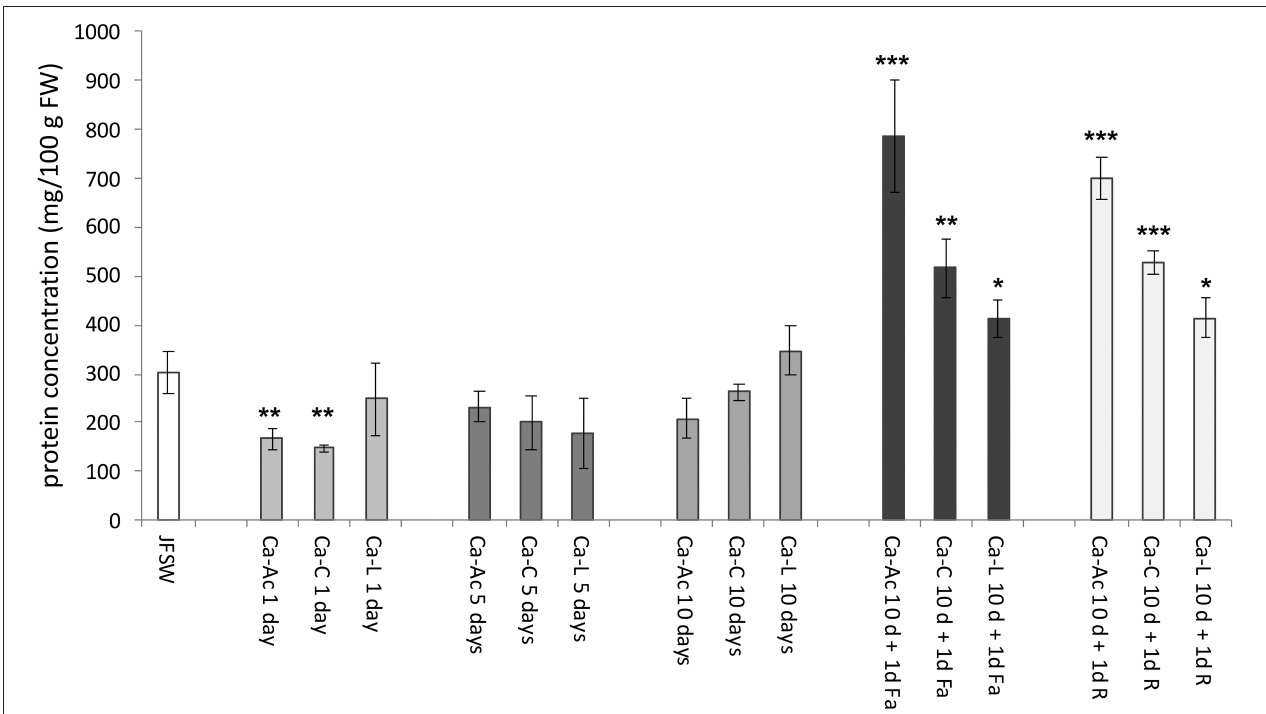
FIGURE 2 | Protein concentration in JF samples. Protein contents expressed as mg per 100g of FW (mg/100g FW) in control [jellyfish washed with sterile sea water (JFSW)] and in the different treatments used: Ca-Ac (calcium acetate), Ca-C (calcium-citrate), Ca-L (calcium lactate) for 1, 5, and 10 days; Ca-Ac 10 d + 1d Fa (ferulic acid added to JF already treated for 10 days with Ca-Ac), Ca-C 10 d + 1d Fa (ferulic acid added to JF already treated for 10 days with Ca-C), Ca-L 10 d + 1d Fa (ferulic acid added to JF already treated for 10 days with Ca-L), Ca-Ac 10 d + 1d R (rutin added to JF already treated for 10 days with Ca-Ac), Ca-C 10 d + 1d R (rutin added to JF already treated for 10 days with Ca-C), Ca-L 10 d + 1d R (rutin added to JF already treated for 10 days with Ca-L). Values are the means of three independent measurements, ± standard deviation. ANOVA statistic test, followed by Tukey’s multiple comparison post-test, was performed to compare